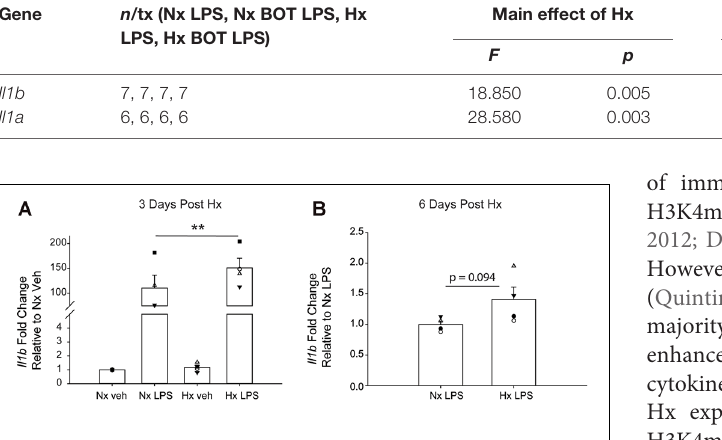
TABLE 4 | Two-way ANOVA results for NF-kB Inhibition with LPS. Gene